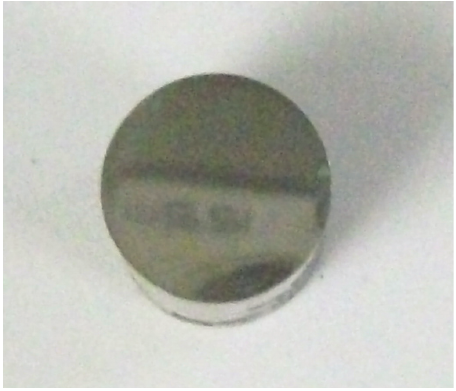
Figure 6 Metallurgical microscope (Metscope-1) image of coating thickness of Ni-nano-Al O composite coatings of AISI 304 stainless 2 3 steel specimen.